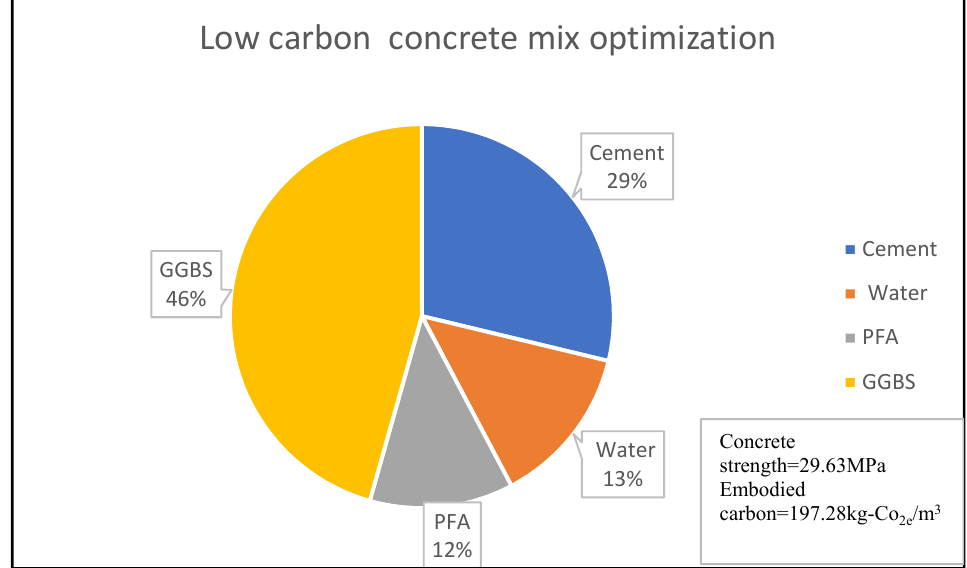
Figure 6. LCC constituent material at water content of 13% for Concrete Batch B [32]. Table 14. Concrete mix optimisation extracted from Concrete Batch C [32].